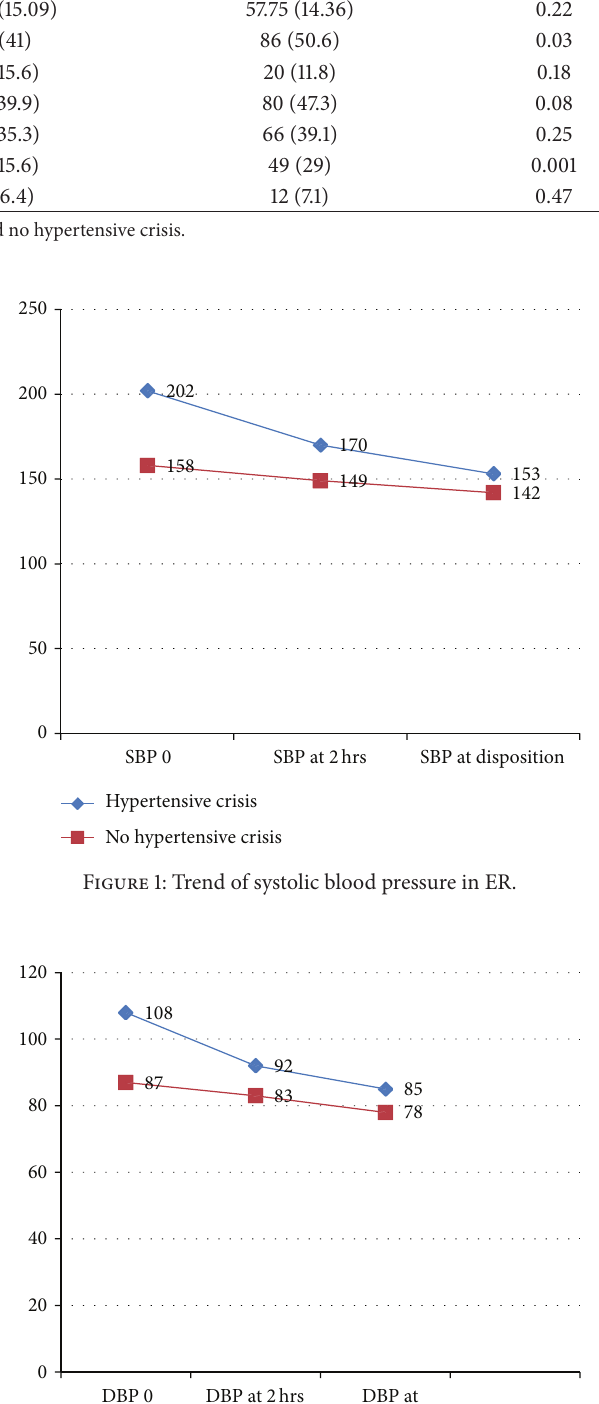
Table 1: Baseline characteristics of patients overall, with hypertensive crisis and without hypertensive crisis ( 𝑁 = 387 ). Characteristics